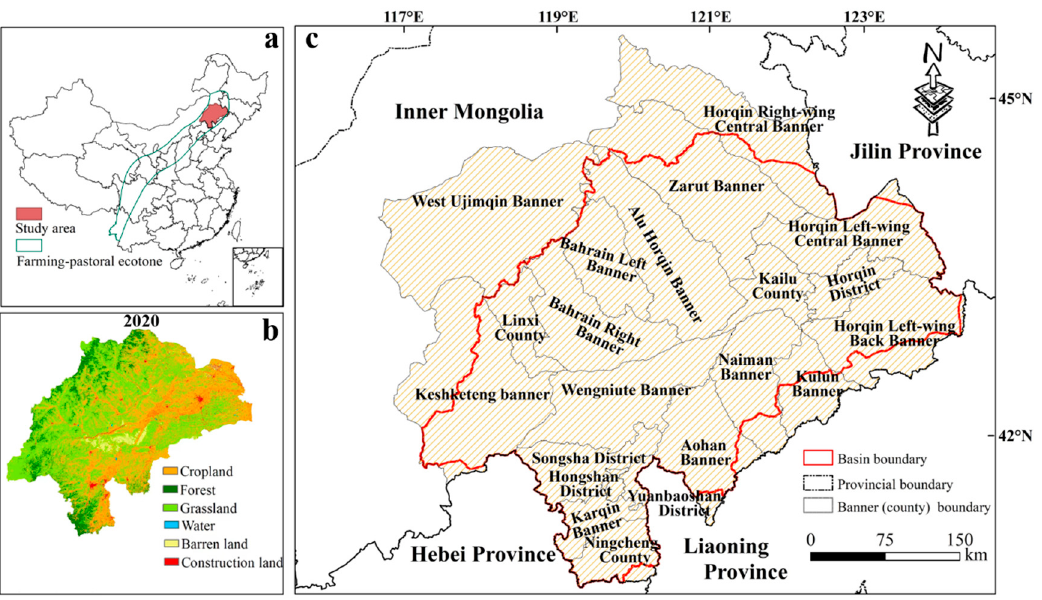
Figure 1. Location of the study area. ( a ) The farming–pastoral ecotone in China; ( b ) the distribution of land use in 2020; ( c ) the 21 counties (banners) covered by the study area.